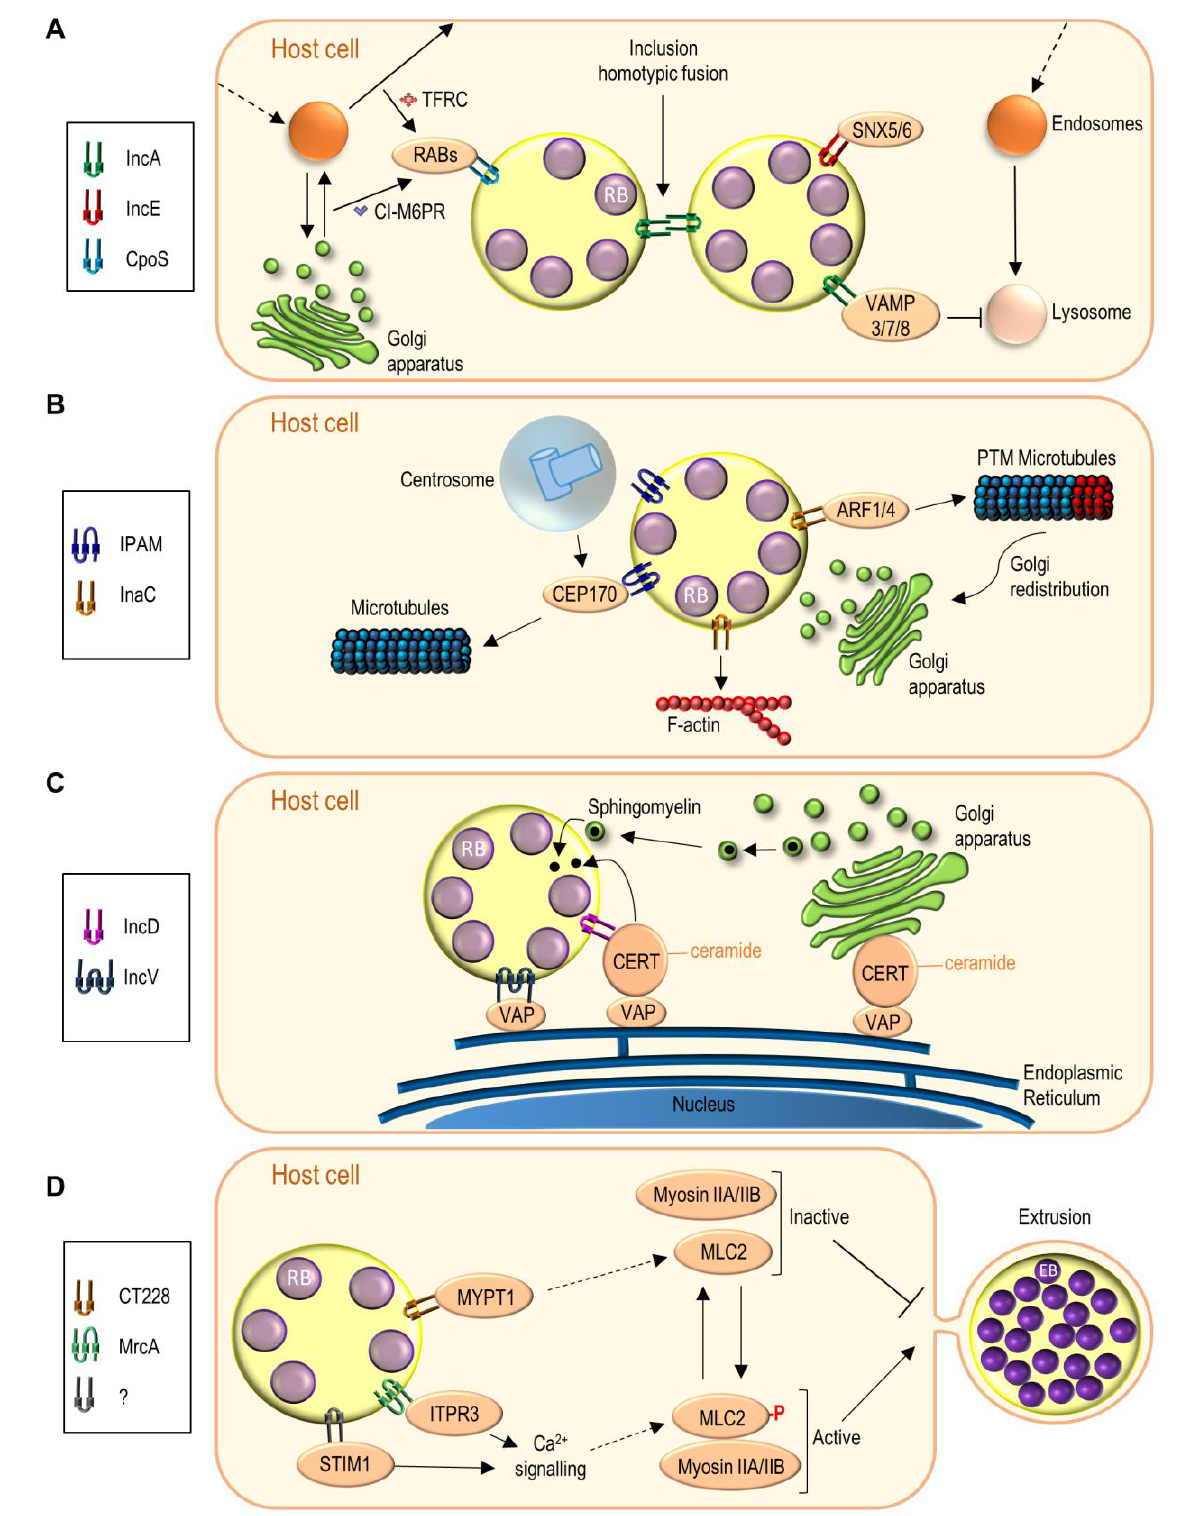
FIGURE 3: Functions of C. trachomatis Incs effectors. (A) Incs subverting host cell vesicular transport (IncA, IncE, CpoS). (B) Incs interfering with microfilaments and microtubules (IPAM, InaC), and mediating Golgi redistribution around the inclusion (InaC); PTM, post- translationally modified. (C) Incs participating in ER-inclusion MCSs (IncD, IncV). (D) Incs modulating chlamydial extrusion by subverting Ca 2+ signalling and myosin II function (CT228, MrcA). An unknown Inc possibly recruits STIM1 to the inclusion membrane. The number of transmembrane domains illustrated for each Inc is based on [42]. See list of abbreviations, main text, and Table 1 for